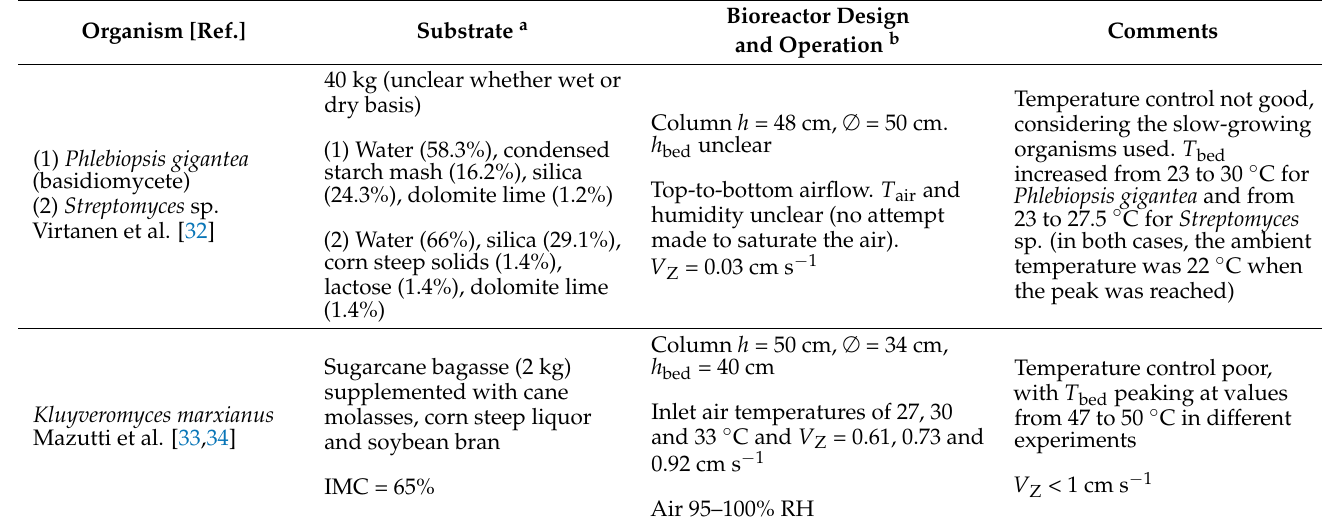
Table 4. Examples of the use of low nominal superficial air velocities with packed-bed bioreactors. Organism